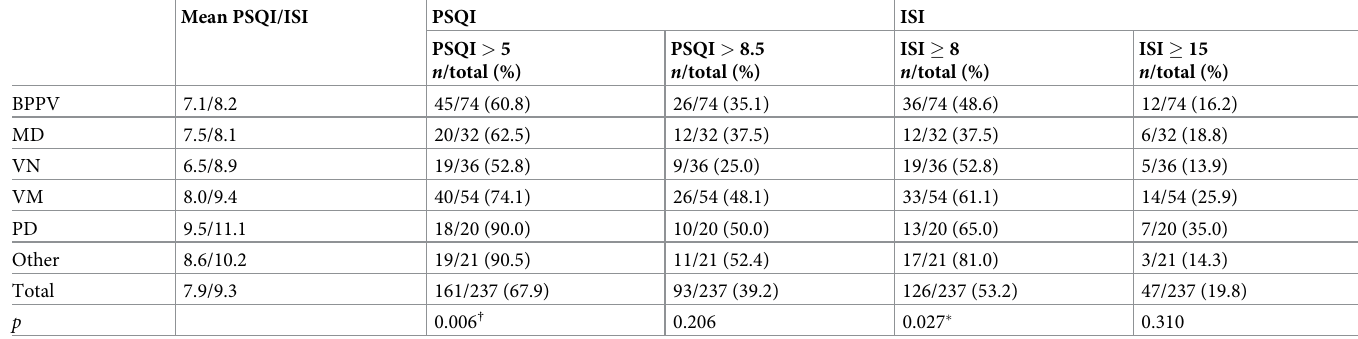
Table 2. Distribution of patients with high PSQI and ISI scores and changes in the sleep disturbance ratio after applying different cut-off values. Mean